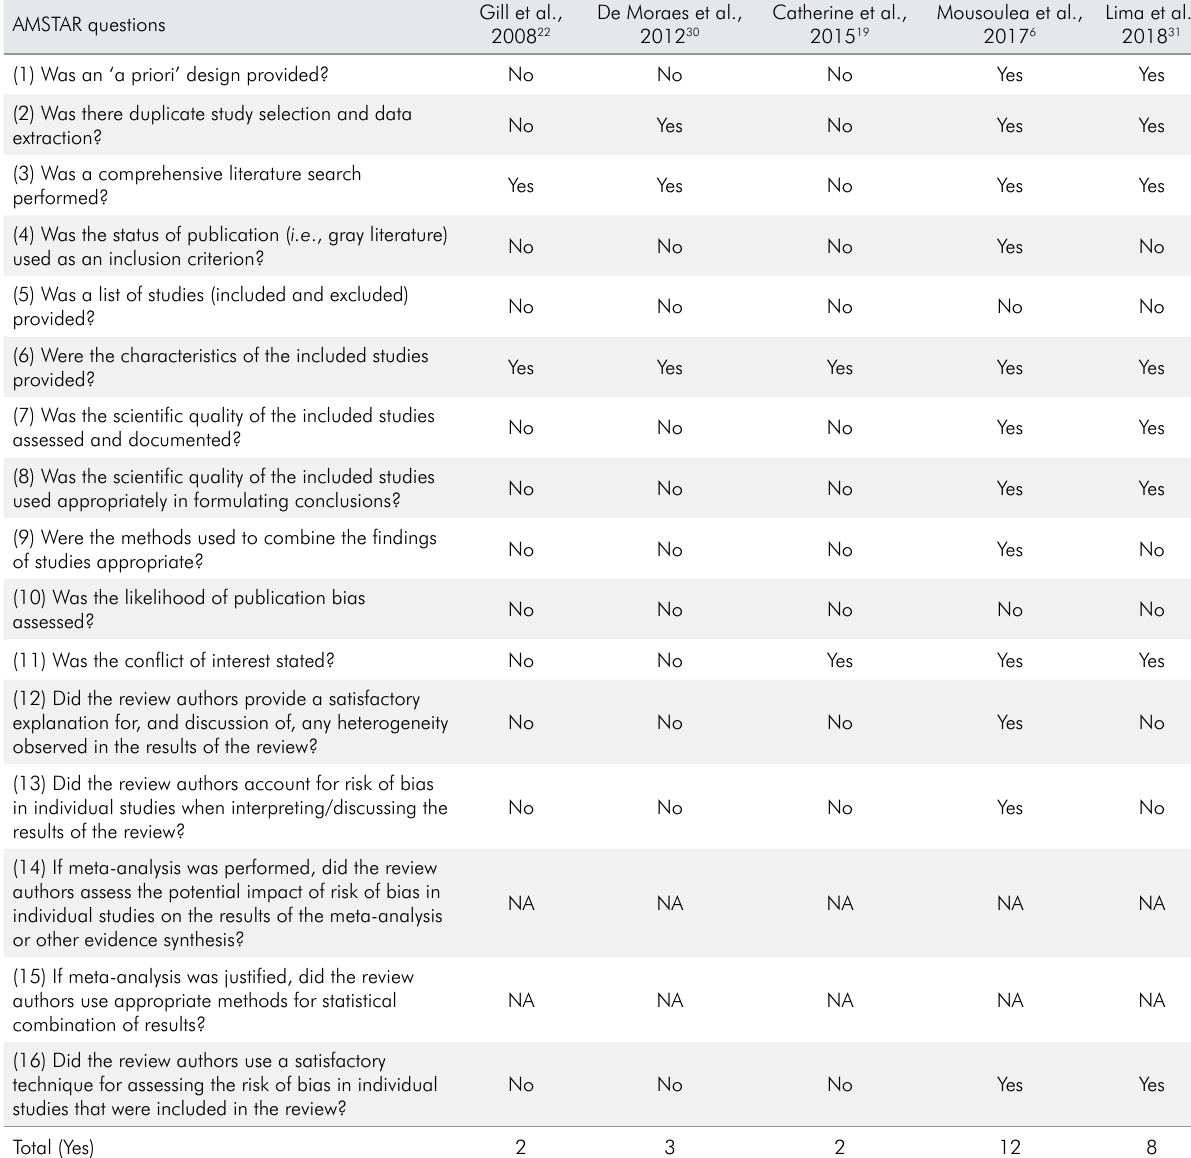
Table 3. Assessment of systematic reviews by AMSTAR scale. AMSTAR